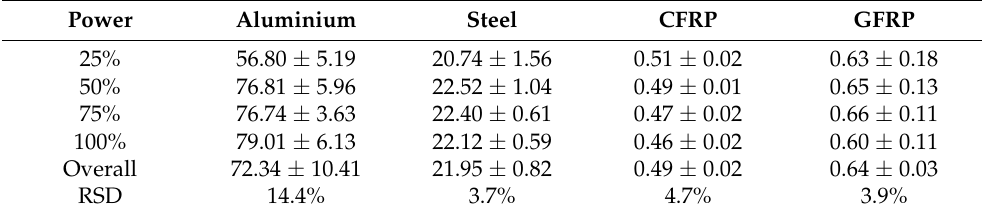
Figure 4. Box charts of the estimated thermal diffusivity (y ‐ axis) with different power percentages (x ‐ axis) for four materials ( a ) Aluminium, ( b ) Steel, ( c ) CFRP, and ( d ) GFRP using the NLSF method. Table 2. Measured thermal diffusivity (mm 2 /s) values with RSD for different power percentages using the NLSF method.